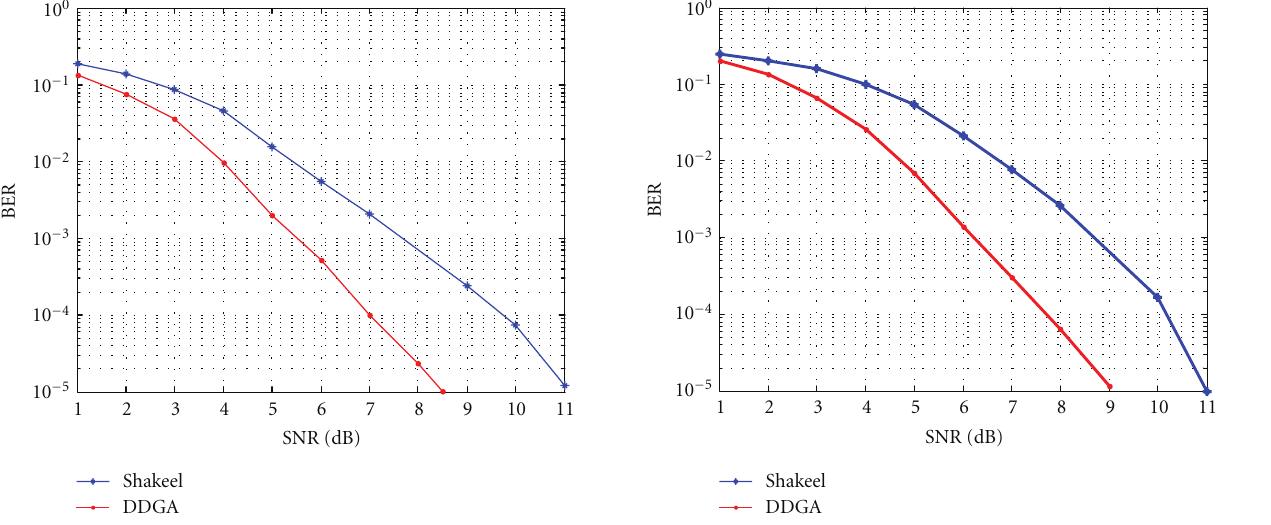
Figure 26: Performances of DDGA, and Shakeel algorithms for QR (71,36,11) code over RC.